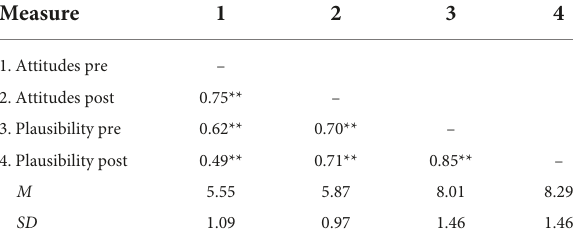
TABLE 2 Bivariate correlations and descriptive statistics for the study